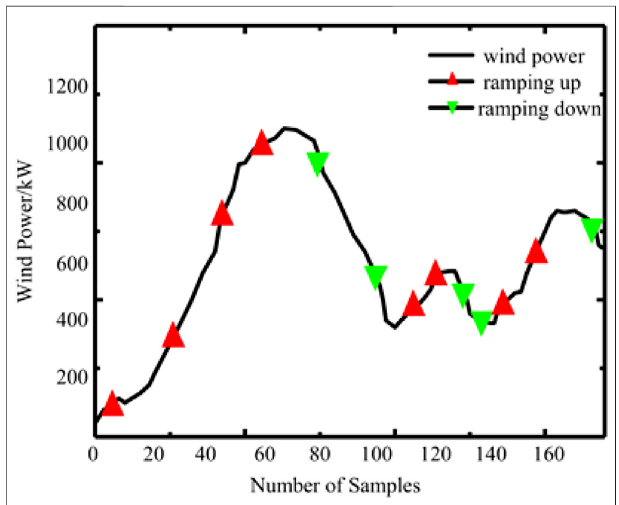
FIGURE 2 | Diagram for identifying ramping